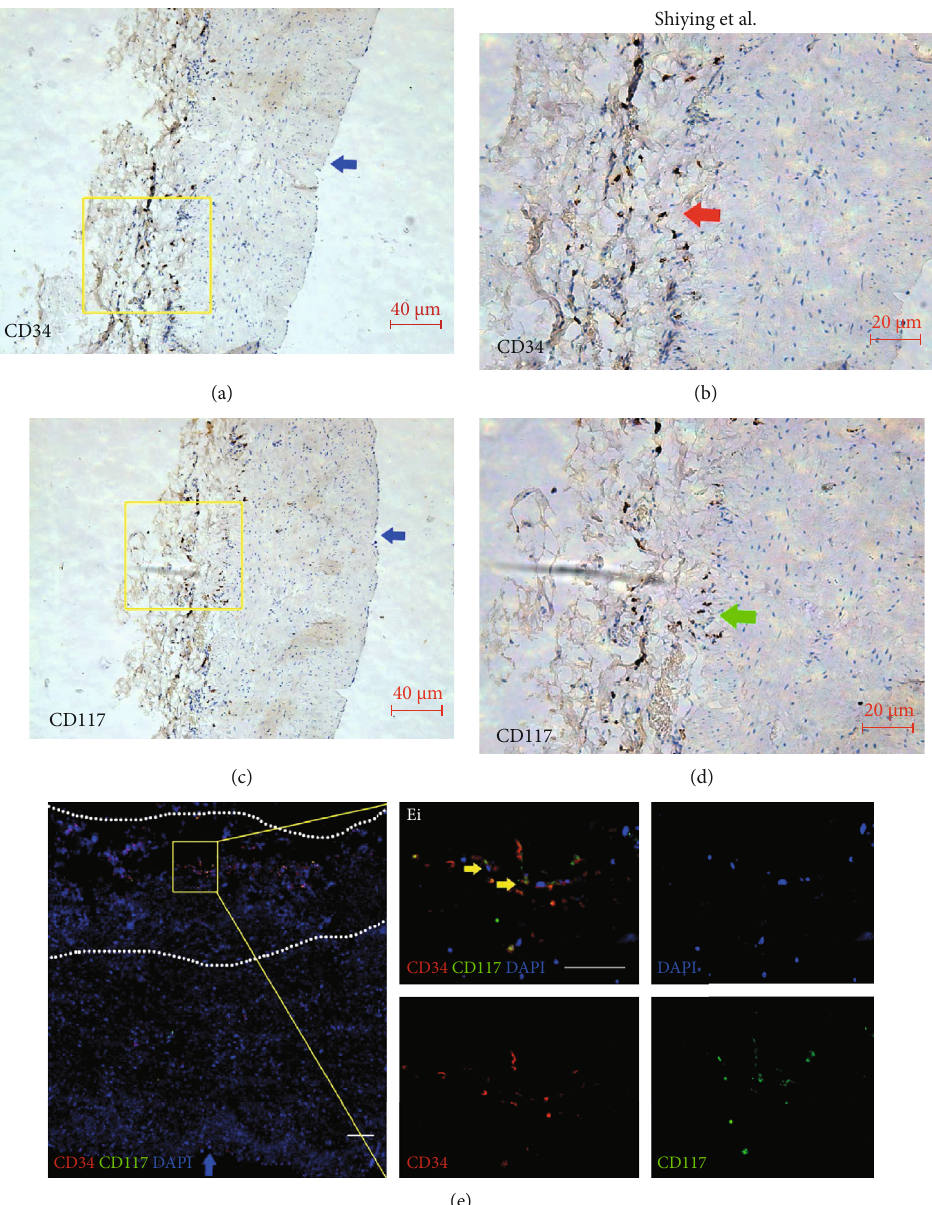
Figure 1: Adventitial progenitor cells in HGSV. The red arrow indicates CD34 + cells. The green arrow indicates CD117 + cells. The yellow arrow indicates double staining of CD34 + andCD117 + cells. The blue arrow indicates the intima of the vein. The white dotted line indicates the border of adventitia. (a, b) CD34 + cells in the adventitia of HGSV. (c, d) CD117 + cells in the adventitia of HGSV. (e) The immuno fl uorescent double staining of CD34 + and CD117 + cells in the adventitia of human saphenous vein. Scale bars: 40 μ m (a,